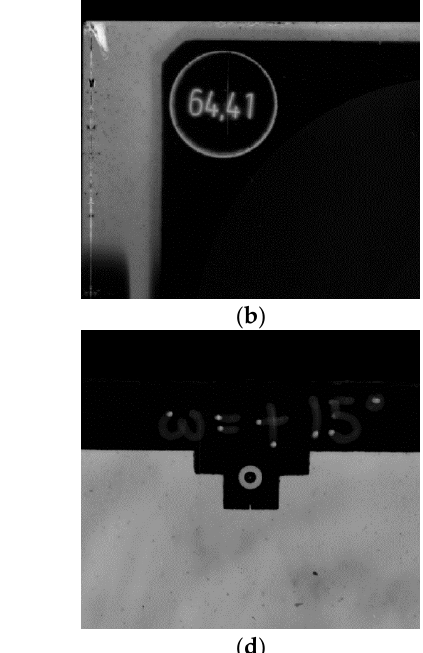
Figure 4. Details of the frame: ( a ) one of the four fiducial marks; ( b ) camera constant in mm written on the frame; ( c ) mark “A” indicates that the image is the left image of a stereo-pair; ( d ) mark “ω = +15°” indicates that the axis of the lens is rotated by 15° upwards.